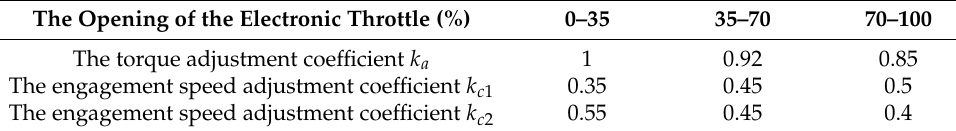
Table 2. The amended rules of the adjustment coefficient. The Opening of the Electronic Throttle